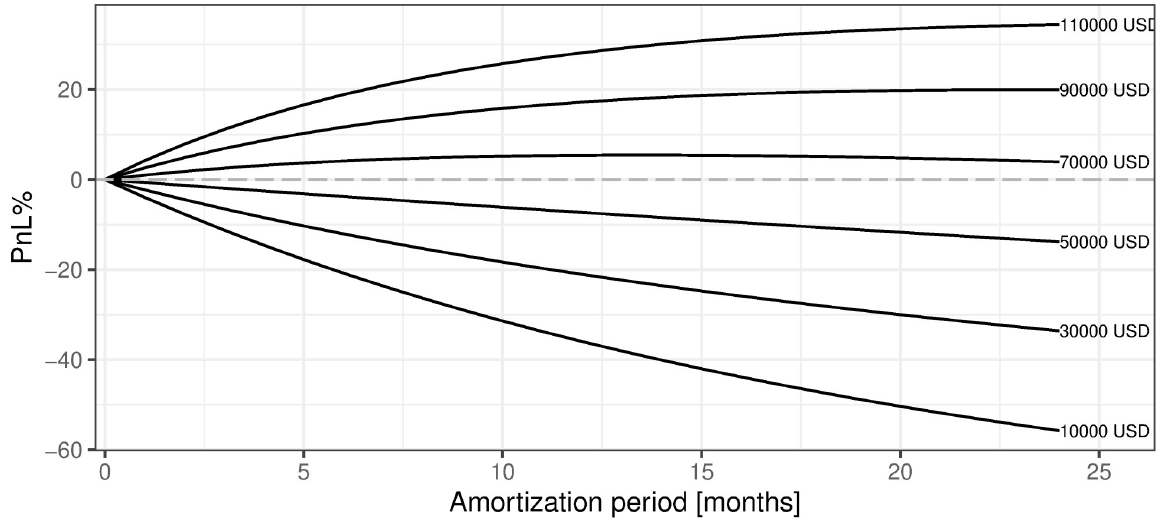
Fig 33. BTC mining profitability (PnL%) different amortization period and different levels of BTCUSD. Note: PnL%, calculated according to the formula 6. The hypothetical amortization period ranges from 0 up to 24 months and BTCUSD price ranges from 10000 USD up to 110000 USD. Other parameters are assumed as outlined in the section Values of variables as of 2021/12/03. Source: own calculations based on data described in section Crucial assumptions and data.